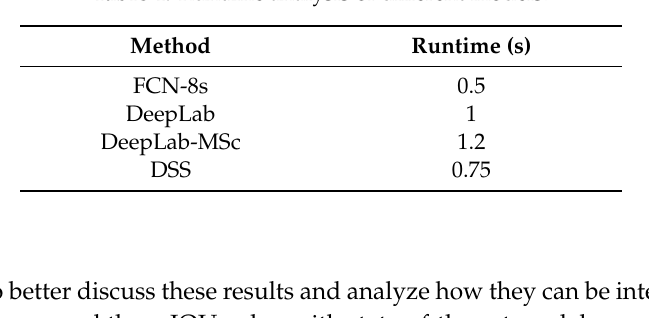
Table 4. Runtime analysis of di ff erent